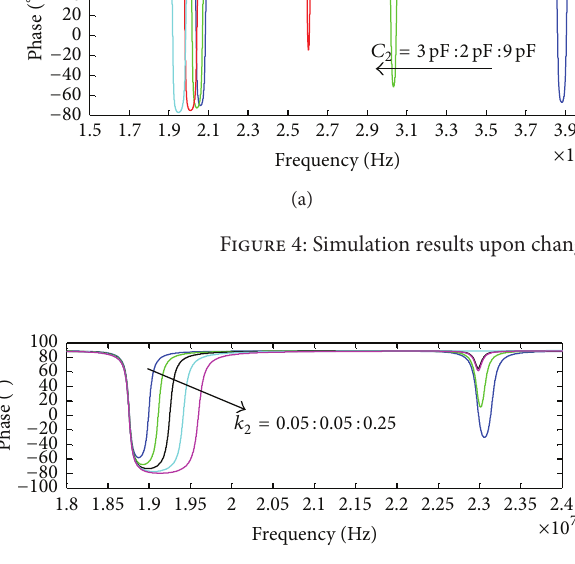
Figure 5: Simulation results upon changing 𝑘 2 . Figure 6: Simulation results upon changing 𝑘 12